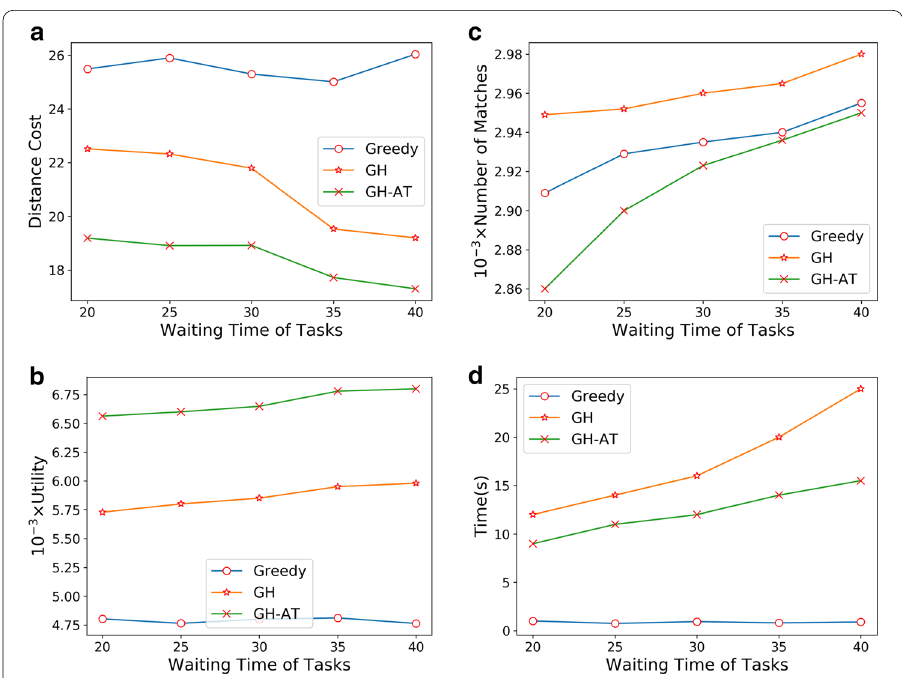
Fig. 7 Varing the waiting time of